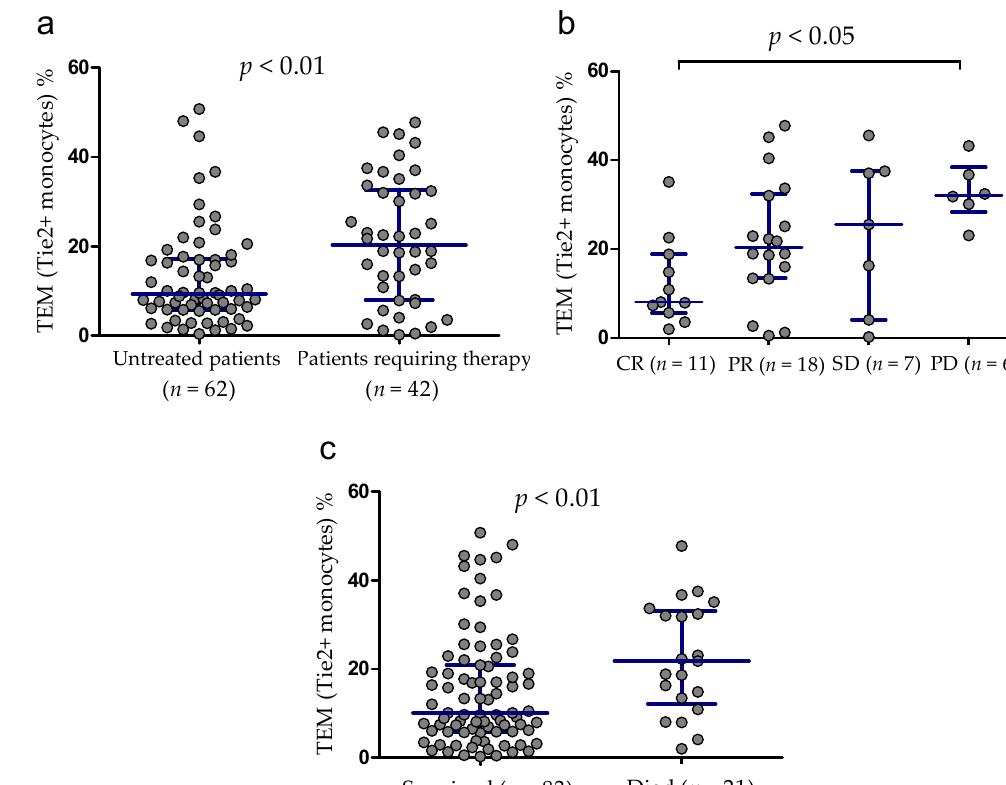
Figure 4. Tie2+ monocytes (TEM) percentage in patients requiring therapy as compared to patients without treatment during the observation period ( a ). The percentage of TEMs in patients responding to treatment and those with progressive disease ( b ). TEM percentage in CLL patients who survived and in the group that died during the observation period ( c ). Scatter plots present raw data. The central line shows the median. “Whiskers” represent from the first quartile to the third quartile (IQR, interquartile range). CR, complete response; PR, partial response; SD, stable disease; PD, progressive disease.